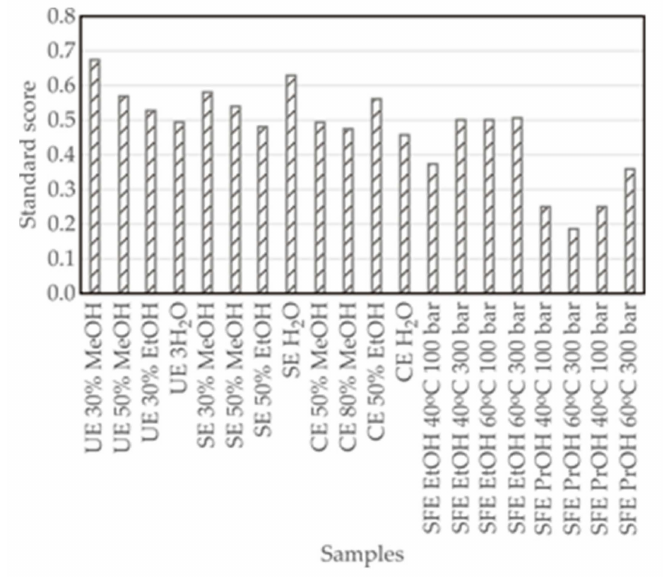
Figure 2. Standard score of extraction techniques: ultrasound (UE), Soxhlet (SE), cold extraction (CE) techniques and supercritical fluid extraction (SFE) based on total phytochemicals, antioxidant and pharmacological